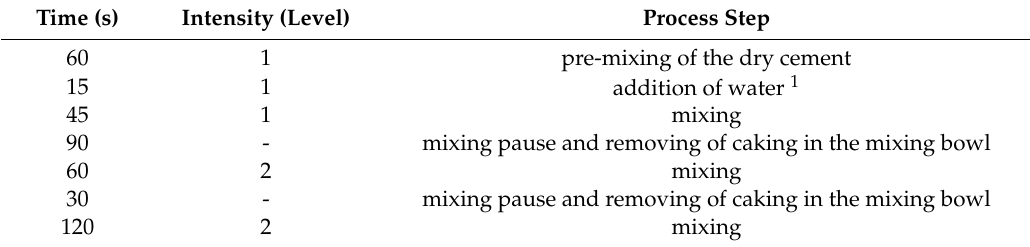
Table 1. Mixing procedure for the cement suspensions.